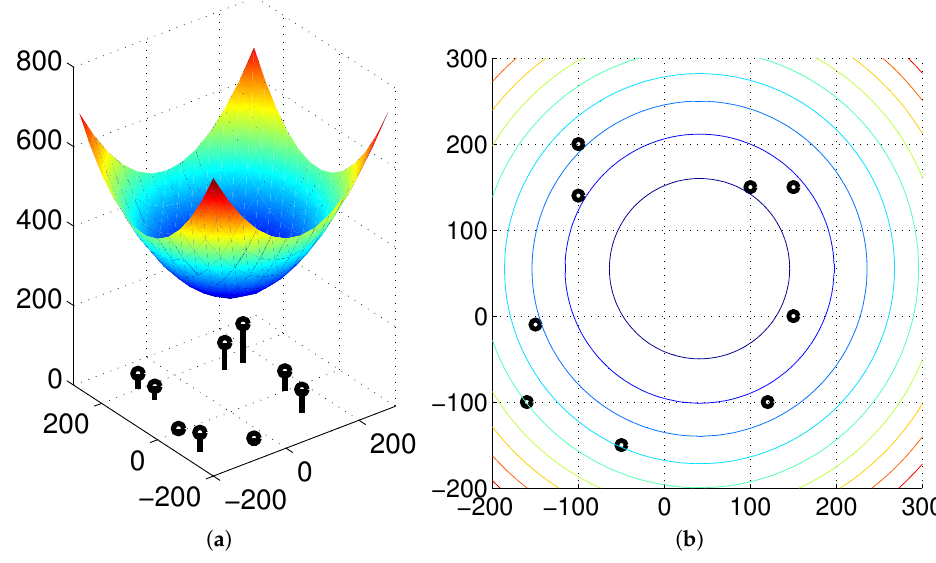
Figure 5. Moment measure as a potential function where the landmark height is regarded as a feature value: ( a ) potential function, ( b ) contour